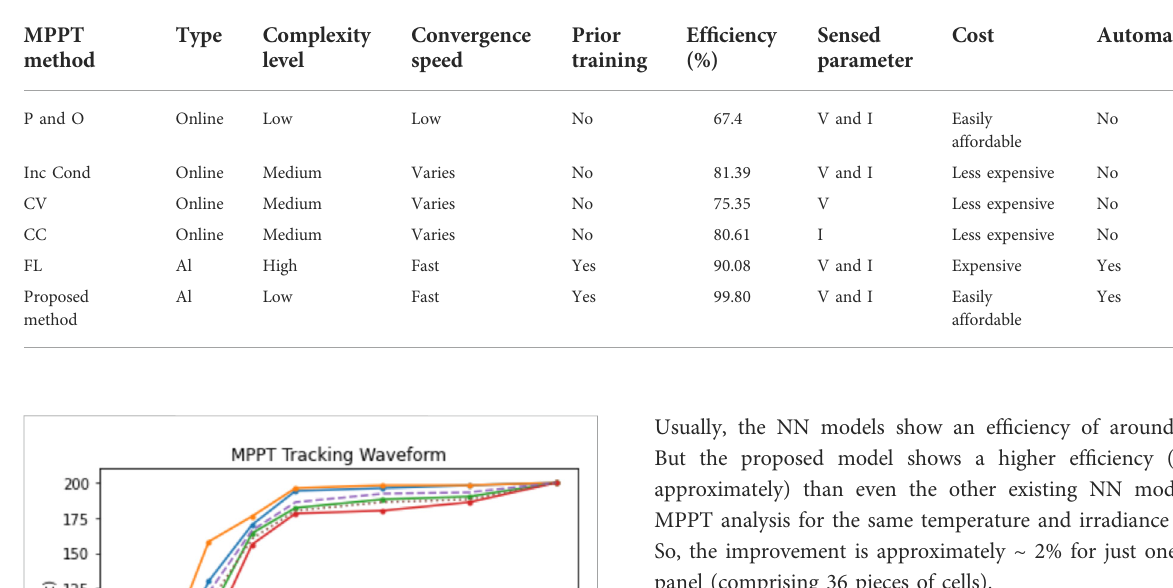
TABLE 6 Comparison with other conventional and popular MPPT methods.